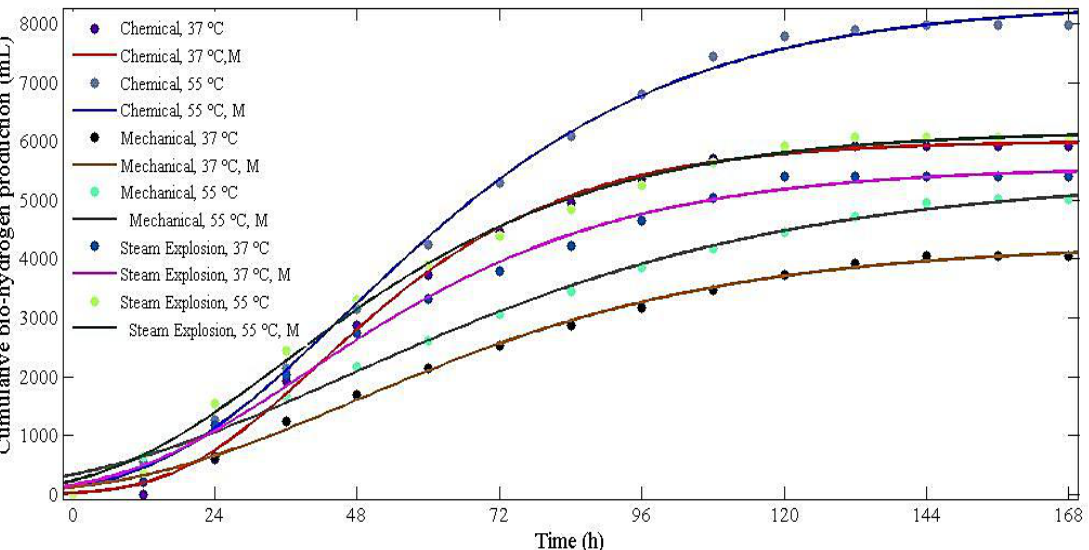
Figure 2. Cumulative bio-hydrogen production under tested treatments. Table 1. Properties of rice straw under different pretreatments.